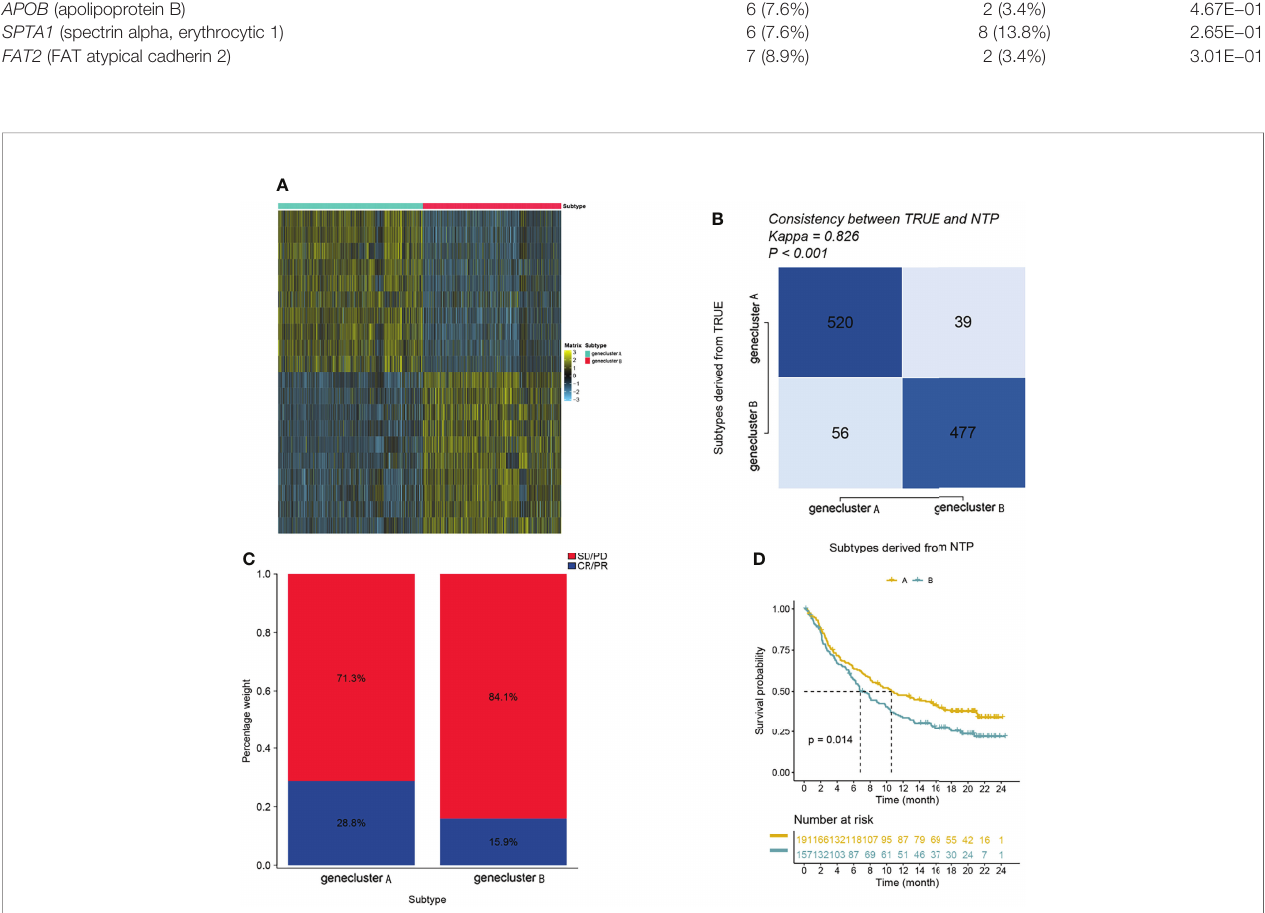
FIGURE 4 | The role of gene clusters in the prediction of immunotherapeutic bene fi ts. (A) Heatmap showing signi fi cantly upregulated biomarkers with subtype speci fi city examined by limma for GBM subtypes. (B) Consistency heatmap using Kappa statistics. (C) Different subtypes with varying anti-PD-1 responses. (D) Kaplan – Meier graphs of different subtypes in the IMvigor210 cohort.